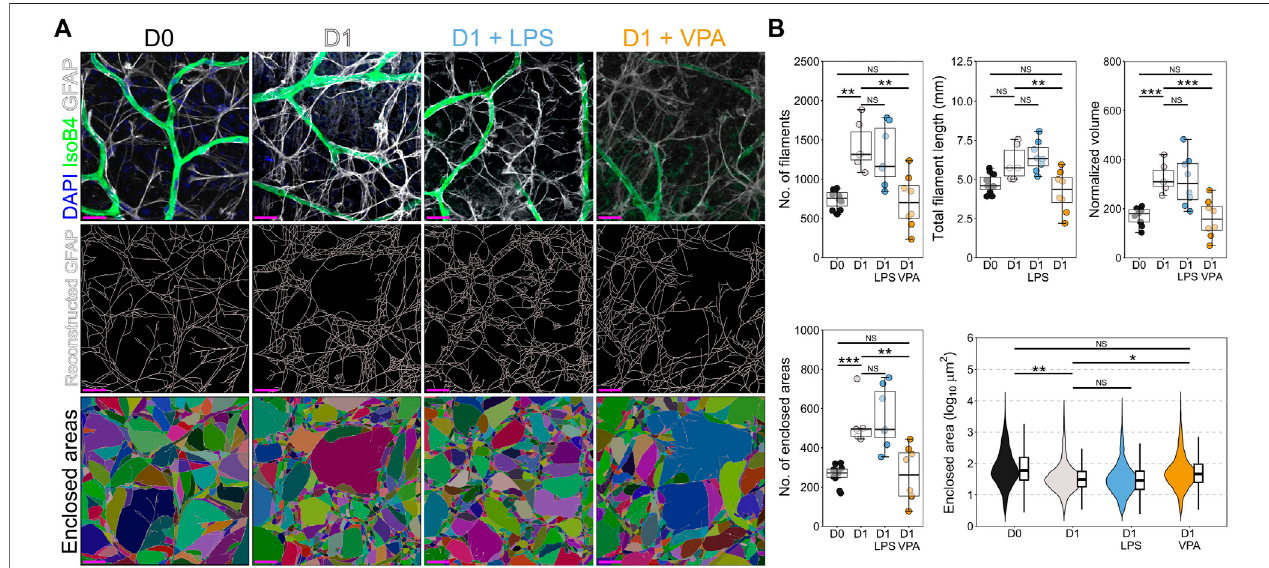
FIGURE 3 | Valproic acid reduces astrocyte morphological changes associated with in fl ammation and gliosis. (A) Retinal explants were exposed to LPS, VPA, or untreated and assessed at D1 in comparison to D0 controls. Individual GFAP fi bers were reconstructed to generate astrocyte networks using Imaris software. Areas enclosedbythese fi bersweregeneratedinImaristomeasurespace fi lling(individualareasaredemonstratedbyauniquecolor). (B) AtD1therewasasigni fi cantincrease in the number of fi laments and the normalized volume, with no signi fi cant change in total fi lament length. This suggests a thickening of GFAP fi laments and an increase in fi lament intersection. Supporting this, the number of enclosed areas was signi fi cantly increased, and these were signi fi cantly smaller (decreased enclosed area)suggesting anincreasein fi lament volumeand space fi llingbytheastrocyte network,asistypical ingliosis.Addition ofLPStothemediahadnosigni fi canteffect